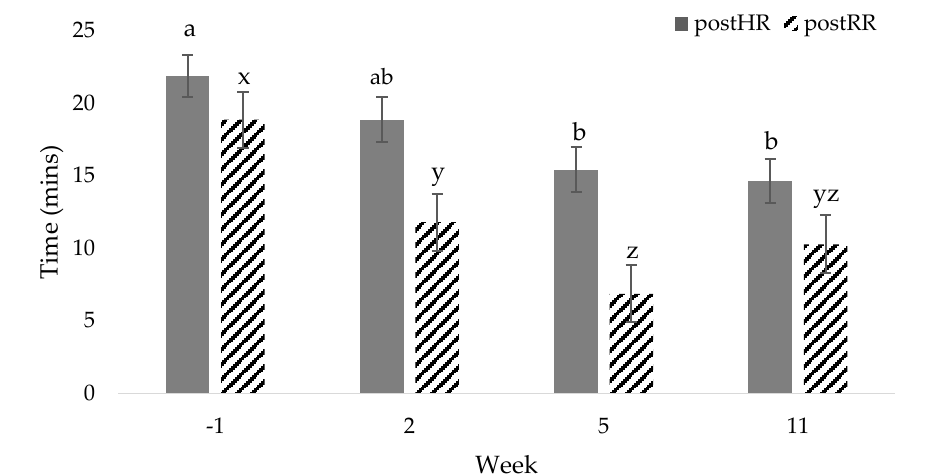
1 TotalHR, total mean heart rate; rHR, resting heart rate; wHR, working heart rate; postHR, post-exercise heart rate. 2 SEM, standard error of the mean, n = 16 for rHR (weeks −1, 2, and 5), n = 14 for rHR (week 11), n = 16 for wHR (week −1), n = 12 for wHR (week 2), n = 7 for wHR (week 5), n = 10 for wHR (week 11), n = 16 for postHR (week −1), n = 14 for postHR (weeks 2, 5, and 11). * Values in a row with an asterisk are different from baseline ( p ≤ 0.05). x Shows the interaction e ff ect between week and diet.